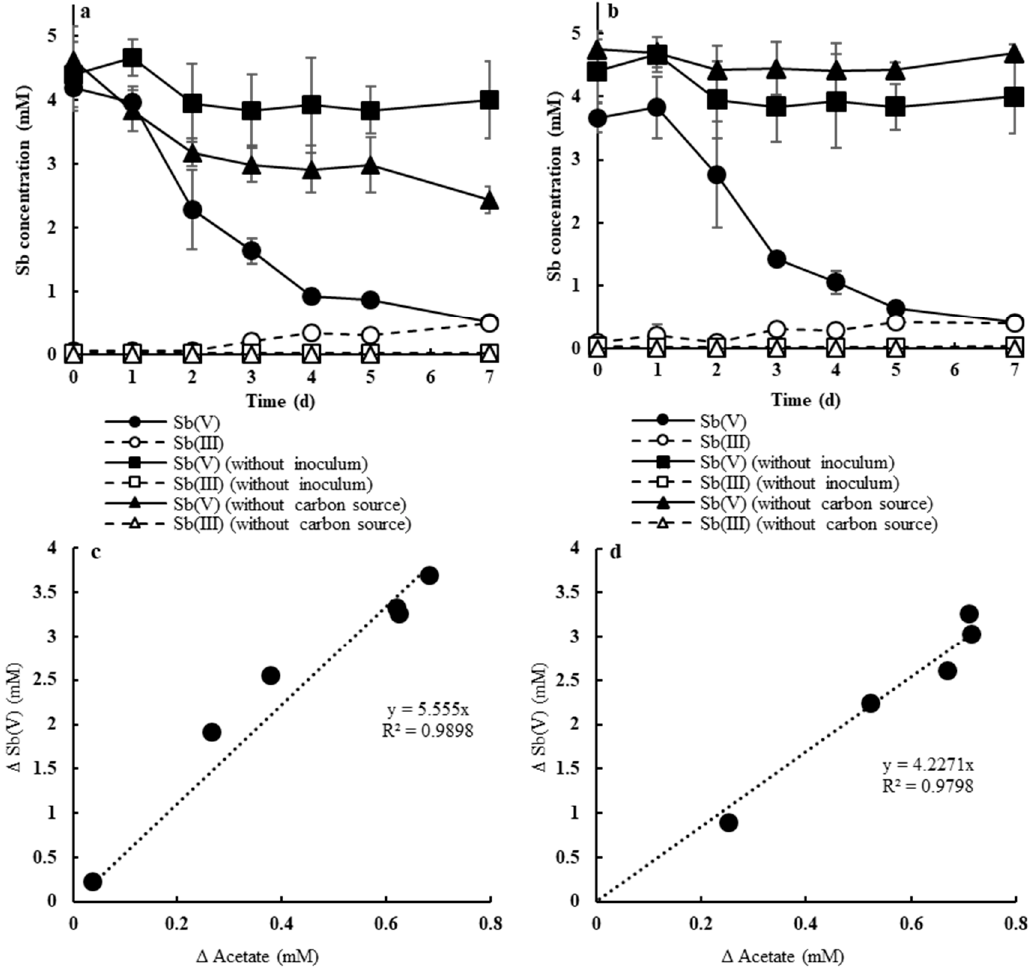
Figure 1. Time course of soluble Sb(V) and Sb(III) ( a , b ) and the relationship between acetate consumption ( Δ Acetate) and Sb(V) decline ( Δ Sb(V)) ( c , d ) during anaerobic Sb(V) reduction by strains AR-2 ( a , c , respectively) and AR-3 ( b , d , respectively). Error bars represent the standard deviation ( n =